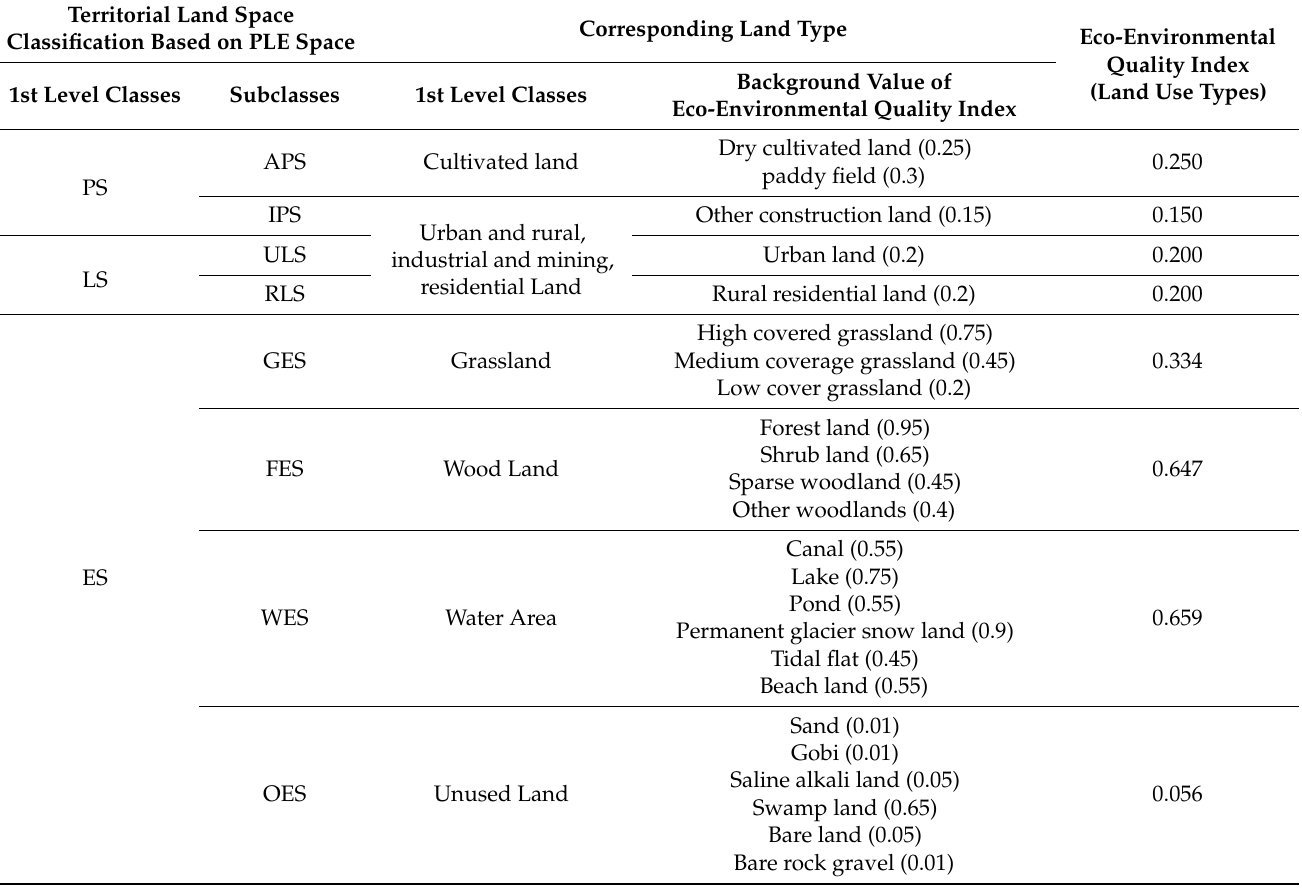
Table 1. PLE land classification system and eco-environmental quality index of land use types in Qinghai